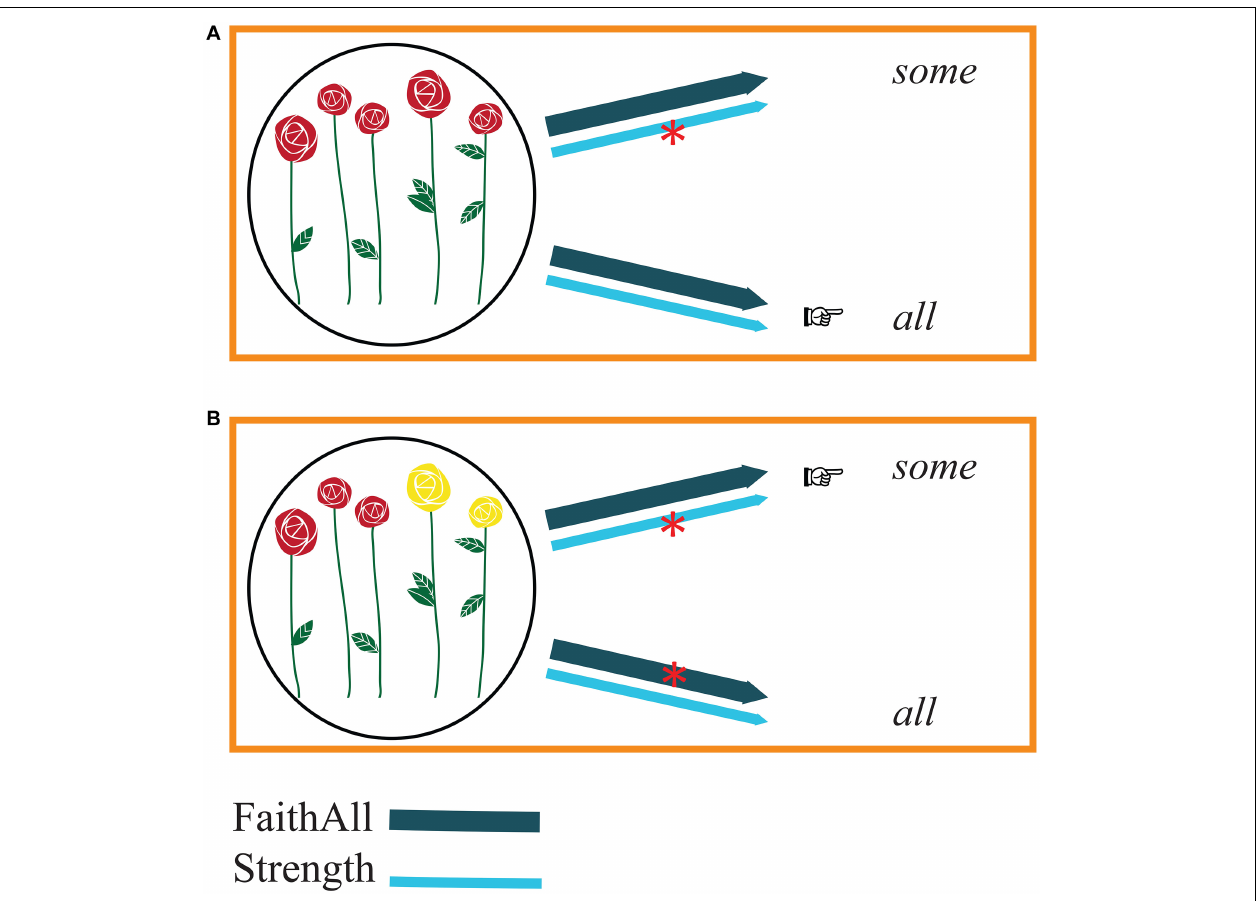
FIGURE 1 | Production (speakers’ perspective). The arrows representing FaithAll (dark blue) and Strength (light blue) link meanings with possible forms. Constraint violations are represented by red asterisks on the arrows. The relative strength of the constraints is indicated by the weight of the line of the arrows: FaithAll is stronger than Strength. Pointing fingers indicate which form proves to be optimal on the basis of the constraints. Panel (A) illustrates reference to a complete set of flowers: the meaning to be expressed corresponds to a complete set of elements. In this case, choosing some would violate Strength. The optimal form, hence, is all . Panel (B) illustrates reference to a subset of red flowers in a larger set of flowers of different colors: the situation in which the meaning to be expressed corresponds to a non-complete set of elements. In this case, choosing some would violate Strength, whereas choosing all would violate FaithAll. However, given that FaithAll is stronger than Strength, the optimal form is some .